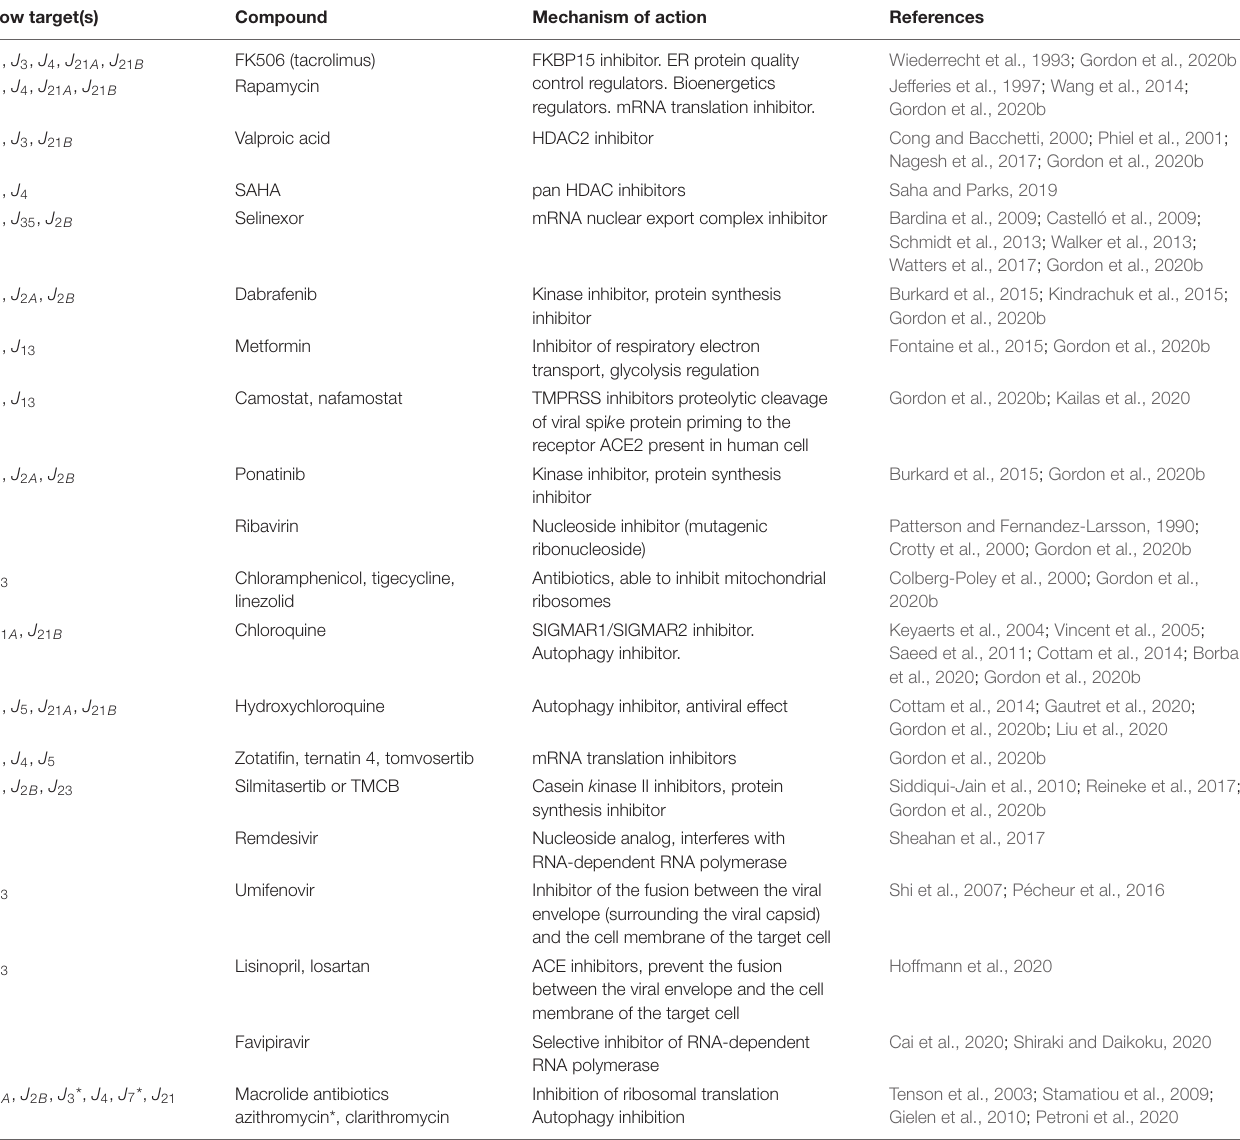
TABLE 3 | Examples of drugs that could act as external forcing factors on identified systemic flow